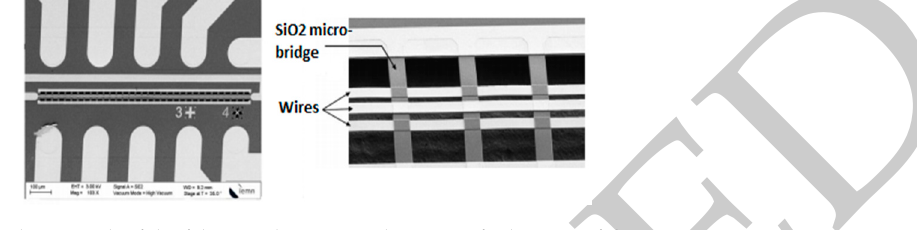
Figure 2. SEM microphotograph of the fabricated sensor with a magnified image of the sensitive section.